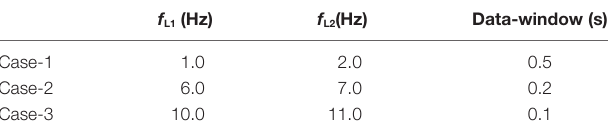
Table 2 | Three kinds of band-pass filter.